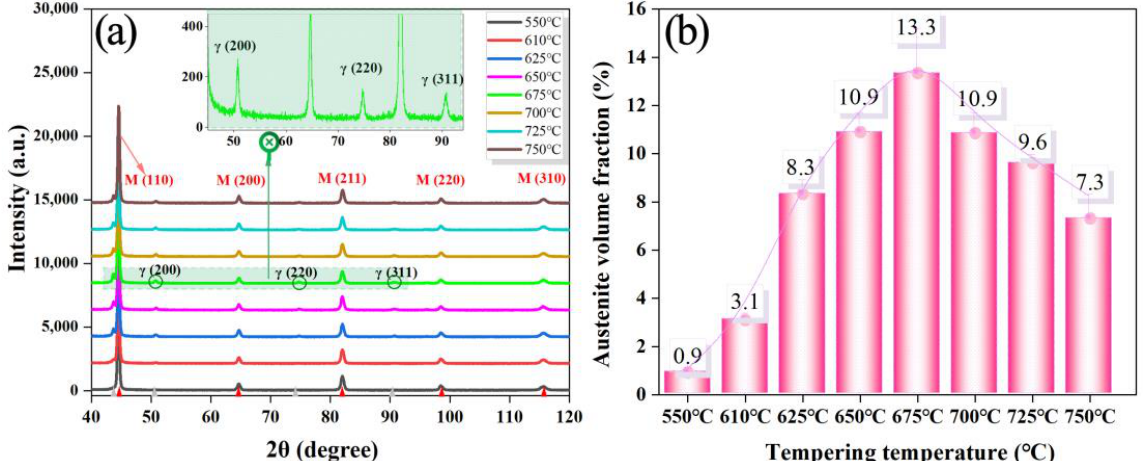
Figure 2. ( a ) X-ray diffraction patterns of the experimental steel treated by quenching and double- step tempering treatment; ( b ) the volume fraction of reversed austenite. tempering treatment; ( b ) the volume fraction of reversed